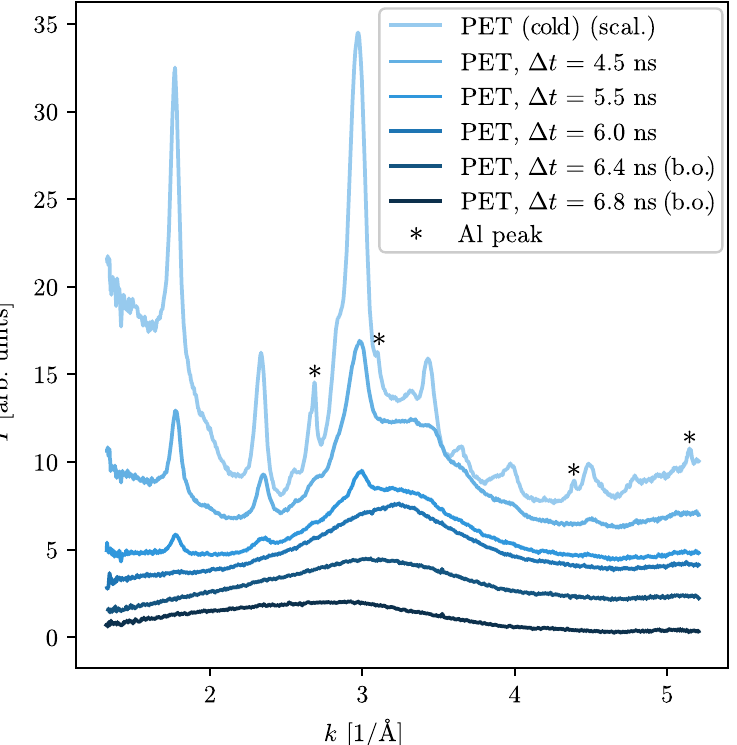
Figure 2. Integrated XRD data at ambient conditions and different time delays between the pump and the probe laser. The cold material shows peaks from the crystalline PET structure as well as from the aluminium coating. With the propagation of the shock front, these features recede and a signal from the amorphous liquid plastic remains, showing a wide peak centred around k peak shifts to lower k , as it can be observed in the curves marked with “(b.o.)”. Those later delays are offset for